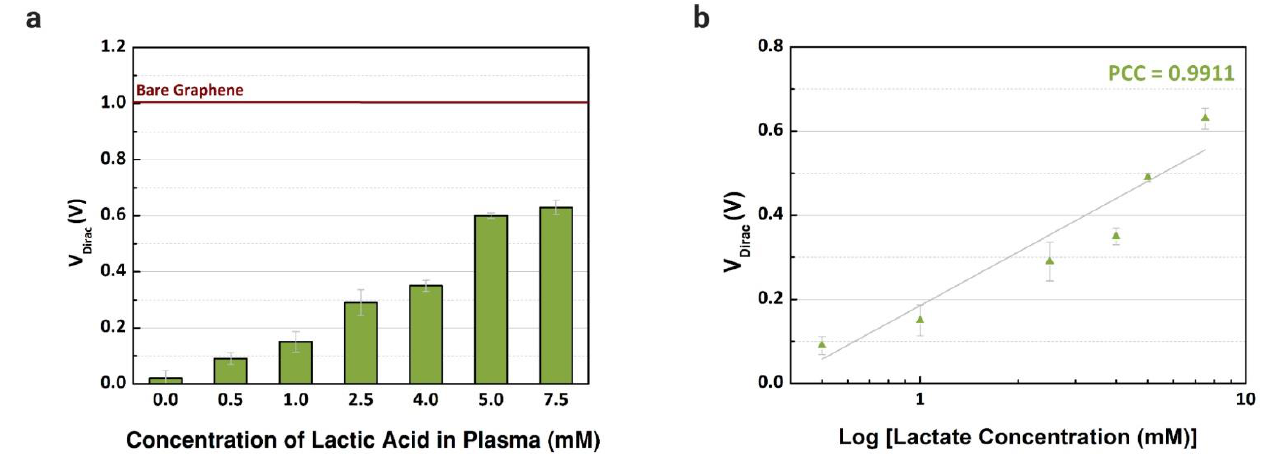
Figure 7. Detection of different concentrations of L-lactic acid in human samples. ( a ) Dirac point voltage values (n = 3) for blood plasma samples treated with L-lactic acid (0 to 7.5 mM). ( b ) Comparison between the shift of Dirac point voltage by concentration of lactate (Pearson coefficient correlations: 0.9911).